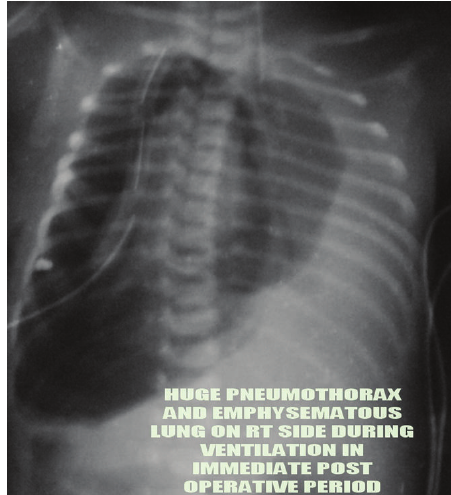
Figure 2: Right sided pneumothorax in the postoperative period.